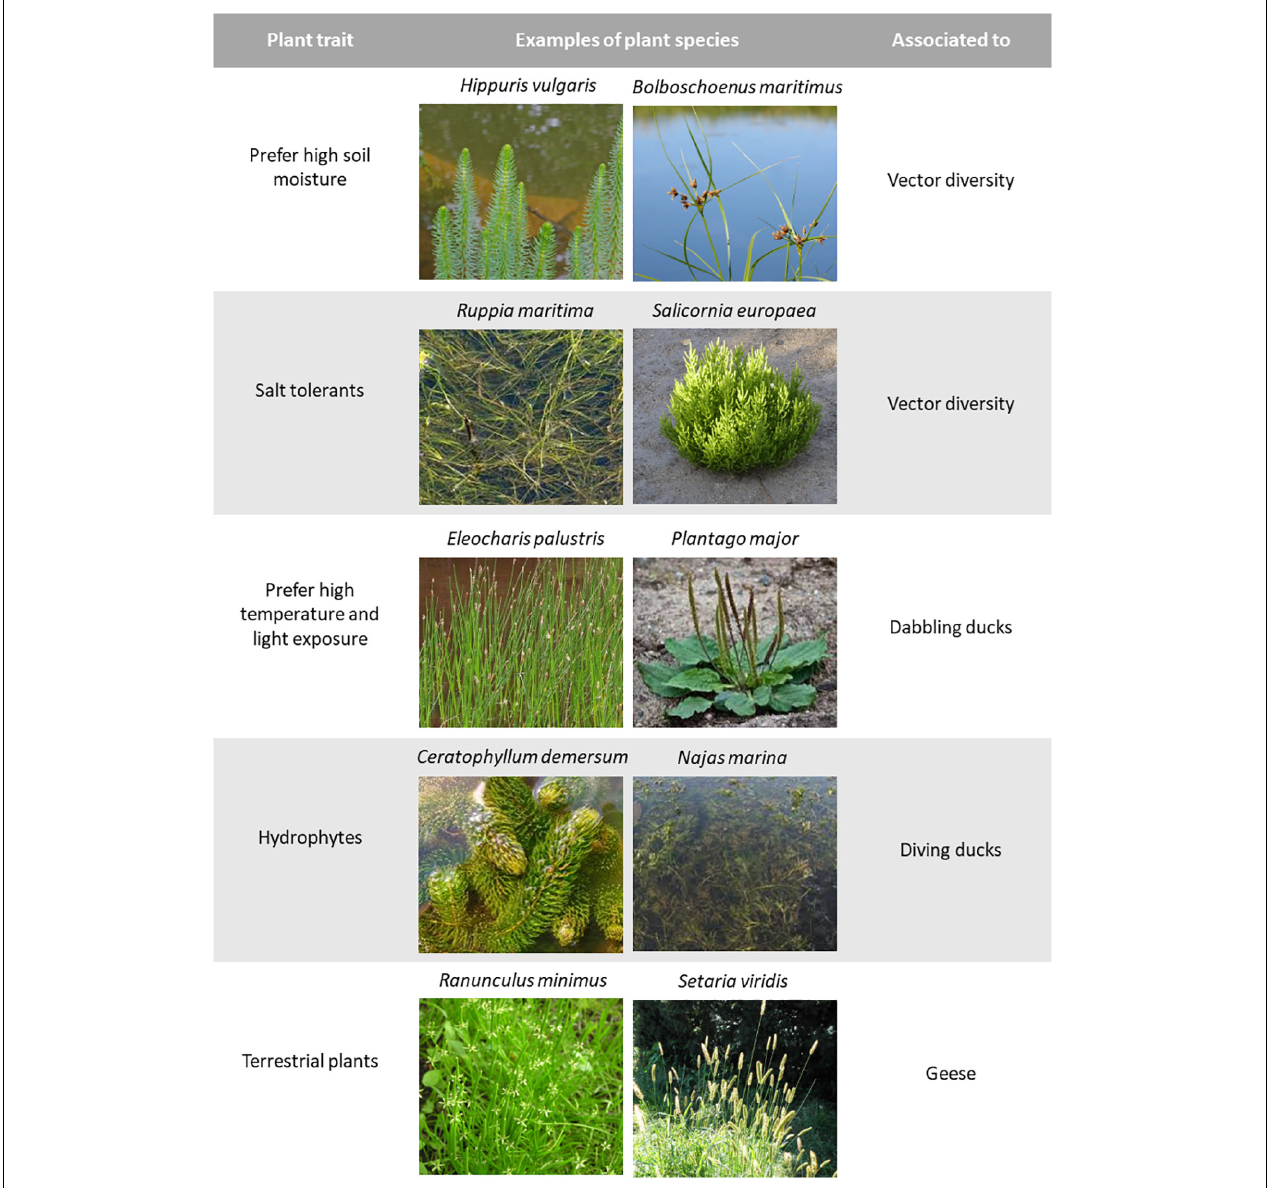
FIGURE 2 | Plant functional traits involved in the main associations found in our RLQ analysis and GAM. We show examples of plant species that present each trait and with what aspect of waterfowl vectors each trait was associated with. Trait values, waterfowl species that ingest seeds of each plant species and credits for the photographs can be found in Supplementary Materials 2, 3, 4 , 8